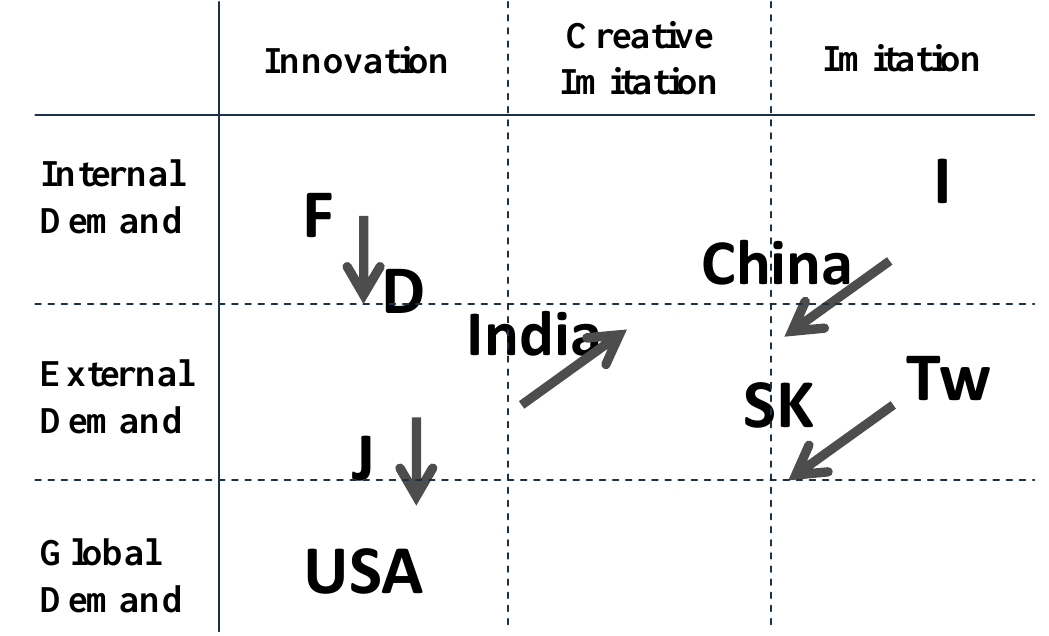
Figure 1: Innovation and Imitation. Global Competition and National Innovation